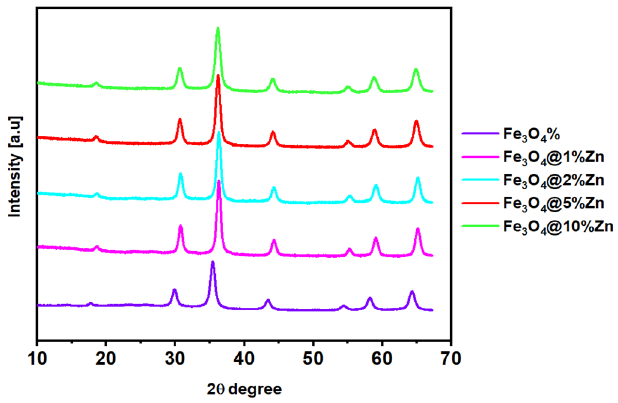
Figure 3. XRD patterns of Fe 3 O 4 , Fe 3 O 4 @1%Zn, Fe 3 O 4 @2%Zn, Fe 3 O 4 @5%Zn, and Fe 3 O 4 @10%Zn.